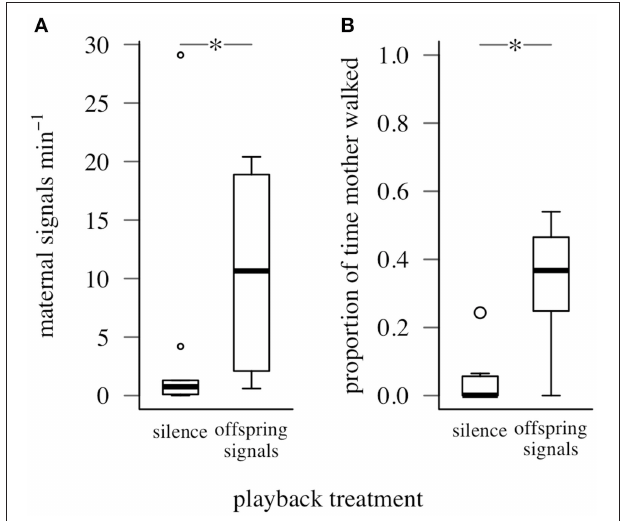
FIGURE 3 | Signaling and walking response of mothers to playbacks of silence and offspring group signals (Experiment 1). *represents PFDR < 0.05, Wilcoxon Signed-Rank Test. Box plots show distributions of (A) maternal signaling rate, (B) proportion of time mothers walked (minimum, first quartile, median, third quartile, maximum; open circles represent